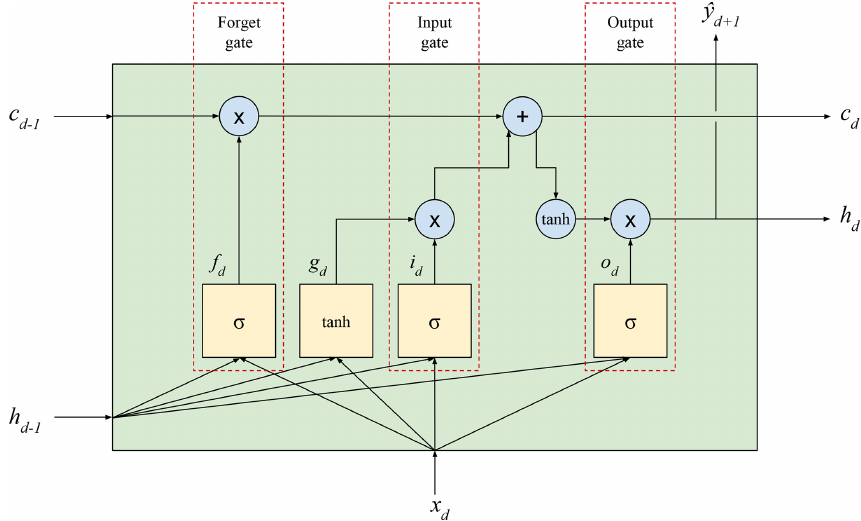
Figure 5. Schematic view of an LSTM